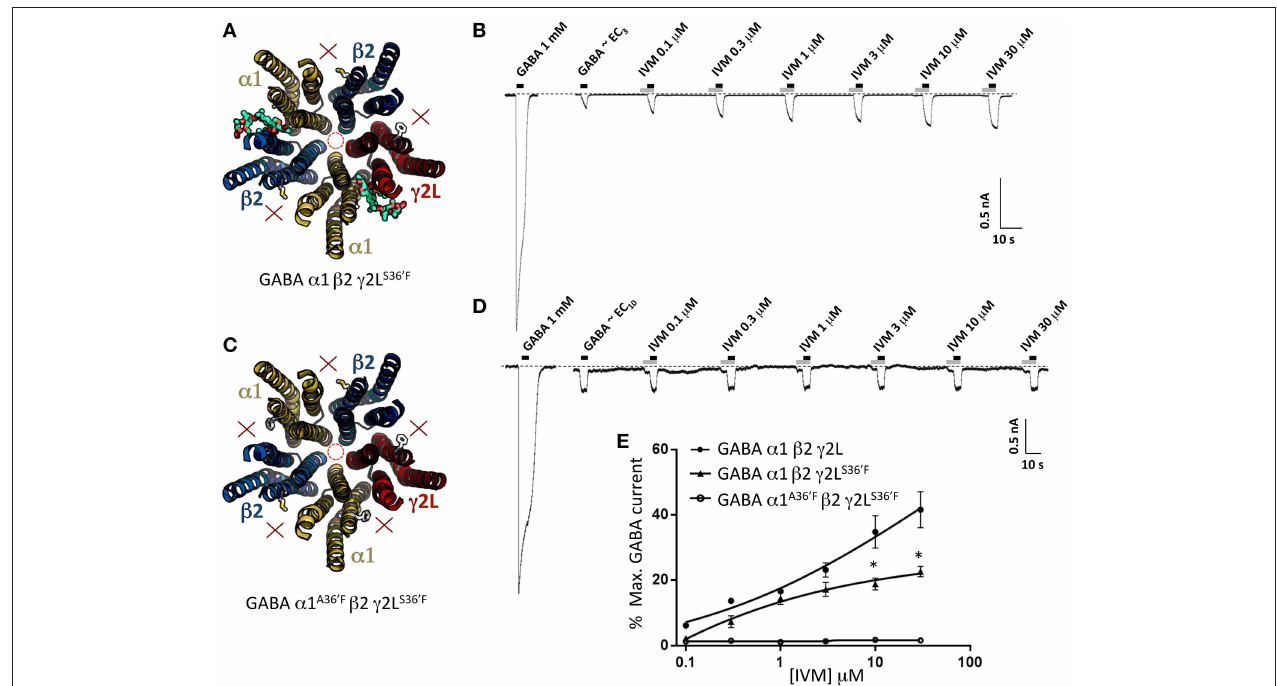
′ F ′ F ′ F and α 1 A36 GABA A Rs. (A) Structural model of α 1 β 2 γ 2L S36 β 2 γ 2L S36 ′ F ′ F showing the lack of ivermectin binding sites. (D) Sample recording showing the effect of increasing β 2 γ 2L S36